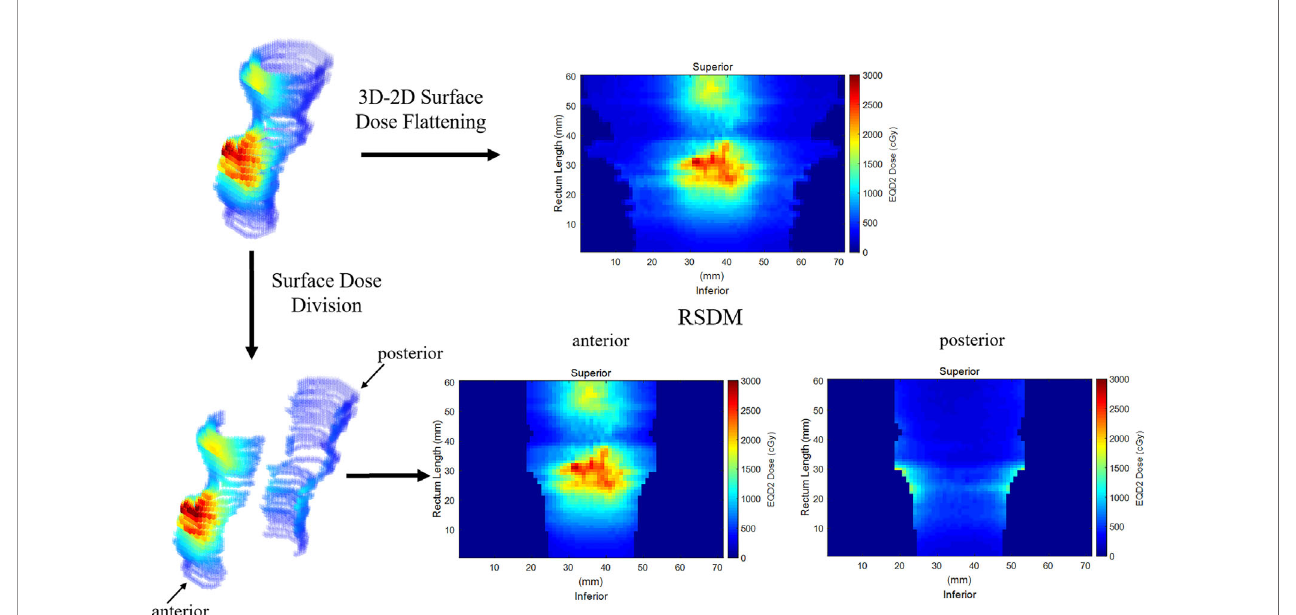
FIGURE 2 | Flattening the 3D rectum surface dose to obtain 2D RSDM. The rectum was subdivided into anterior and posterior parts.